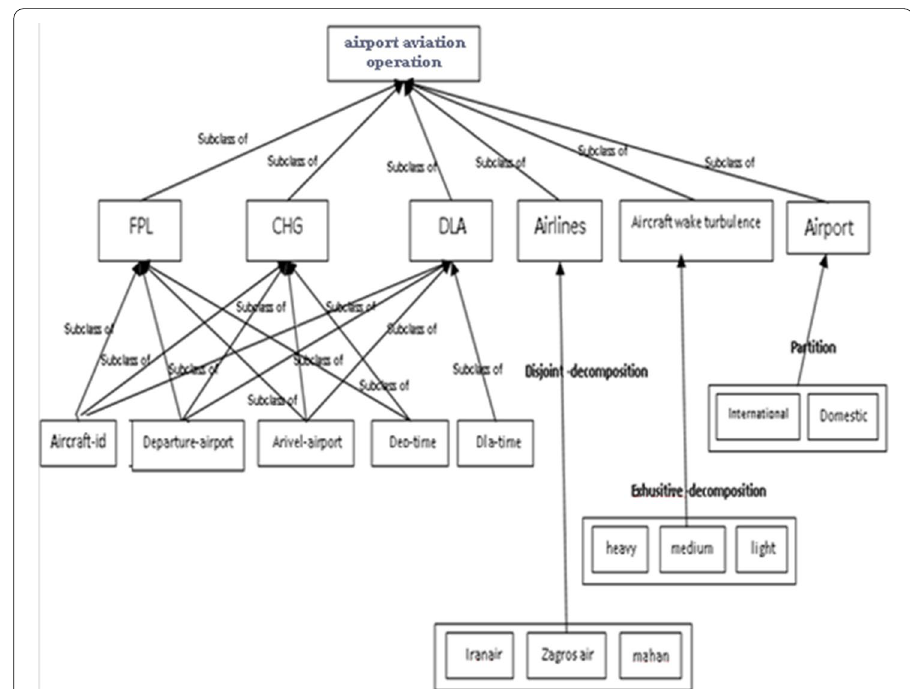
Fig. 12 Hierarchical diagram with taxonomic